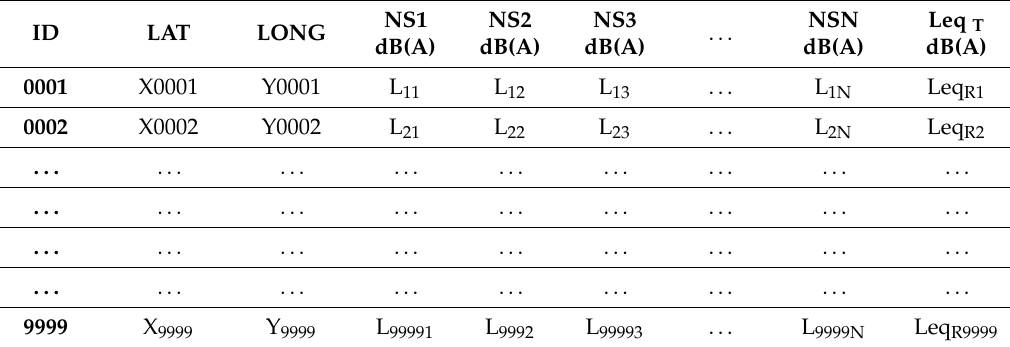
Table 1. Basic noise map